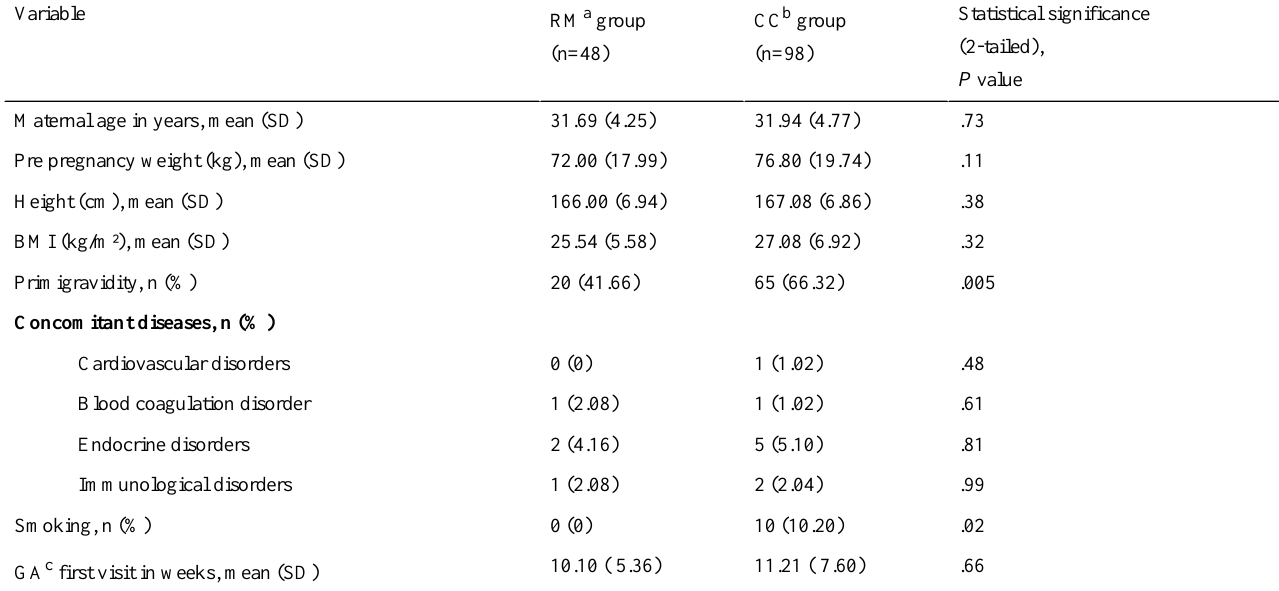
Table 1. Maternal demographics and characteristics.